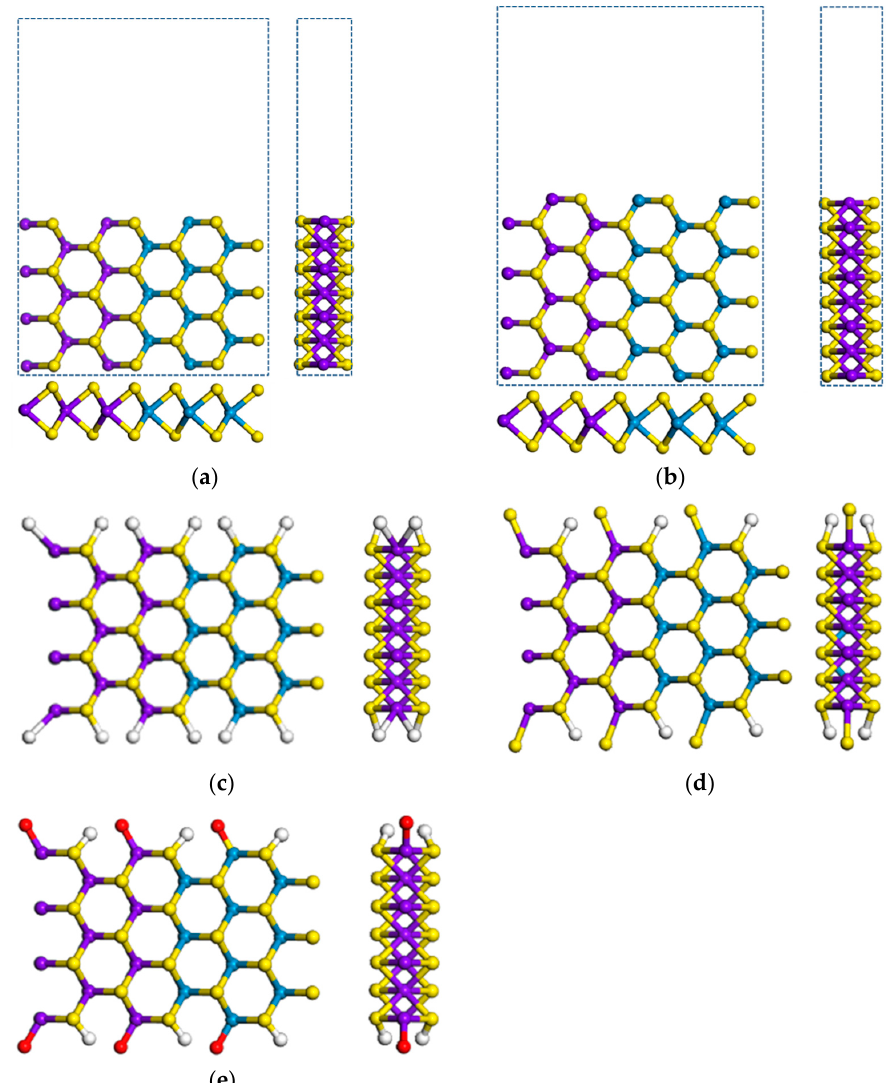
Figure 4. Top and side view of armchair (MoS 2 ) 3 /(WS 2 ) 3 nanoribbons: ( a ) 7-ac-(MoS 2 ) 3 /(WS 2 ) 3 -NR-sym, ( b ) 8-ac-(MoS 2 ) 3 /(WS 2 ) 3 -NR-asym, ( c ) 7-ac-(MoS 2 ) 3 /(WS 2 ) 3 -NR-sym-H, ( d ) 7-ac-(MoS 2 ) 3 /(WS 2 ) 3 -NR-sym -H-S, ( e ) 7-ac-(MoS 2 ) 3 /(WS 2 ) 3 -NR-sym-H-O. The blue dotted rectangle shows the unit cell of armchair nanoribbon with a vacuum region along the y axis in ( a , b ). And ( c – e ) have the same vacuum region as in ( a , b ). Grey represents H atoms, red represents O atoms.